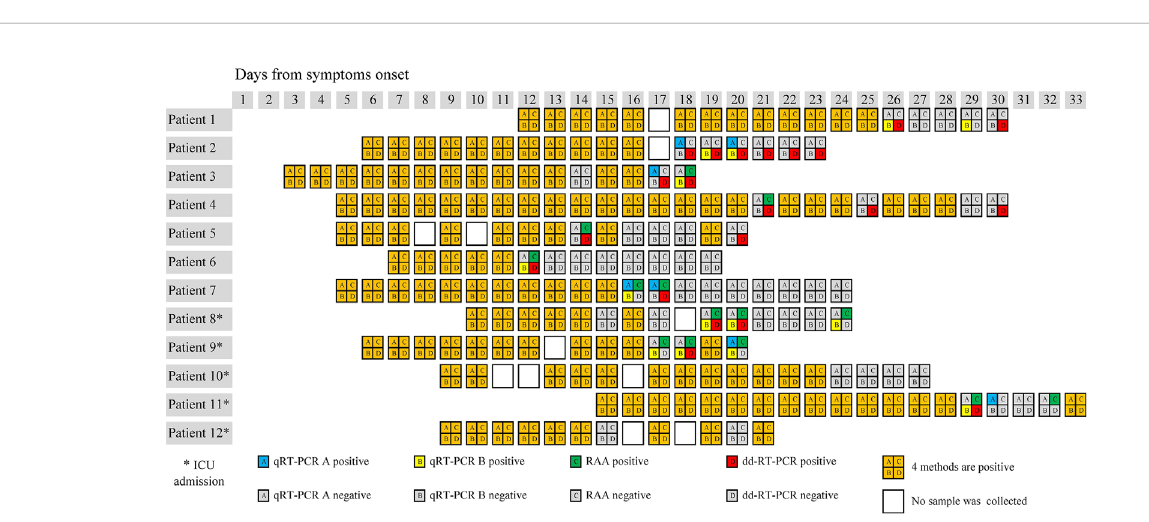
FIGURE 3 | Results of the 4 methods in the testing of 197 saliva samples of 12 patients after